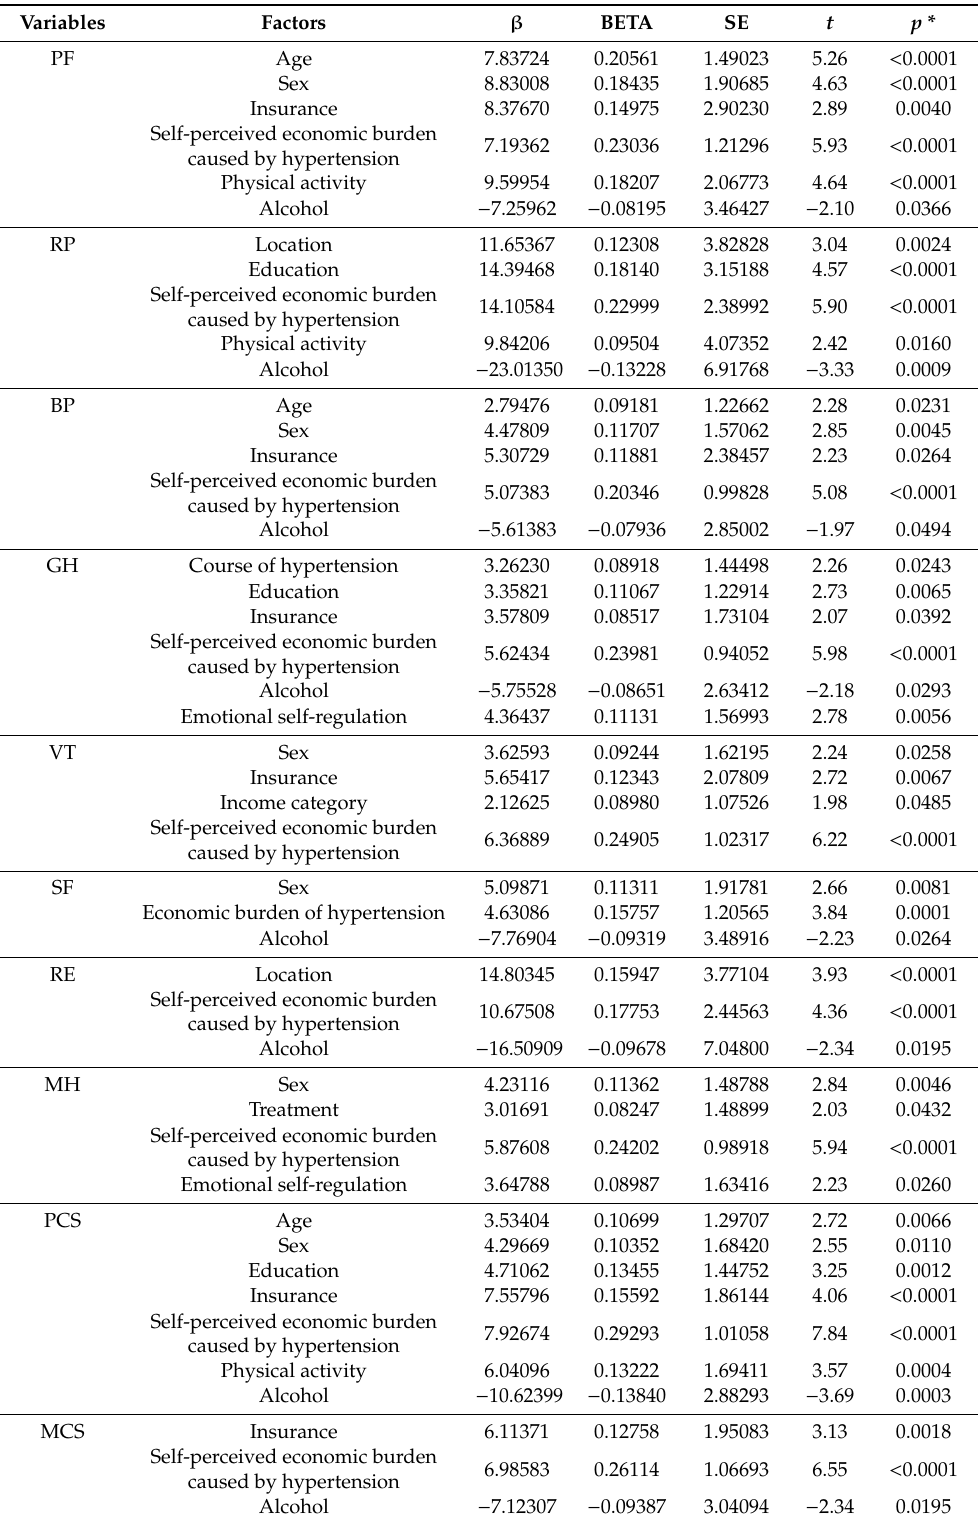
Table 2. Factors associated with the scores of Medical Outcomes Study Short Form Health Survey questionnaire (SF-36) among